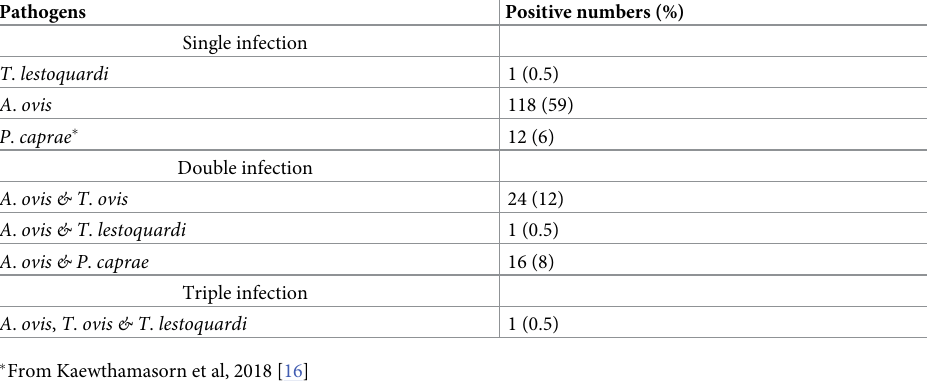
Table 5. Co-infection of pathogens in goat samples from Sistan and Baluchestan province.